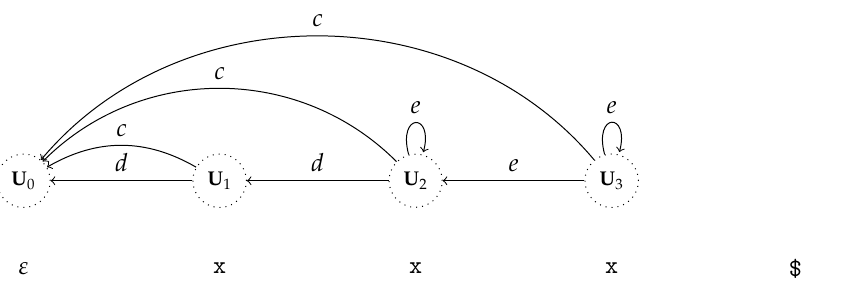
Figure 19. Zoomed-out view of the GSS for the specification Ξ in (4) only displaying the edges resulting from shift